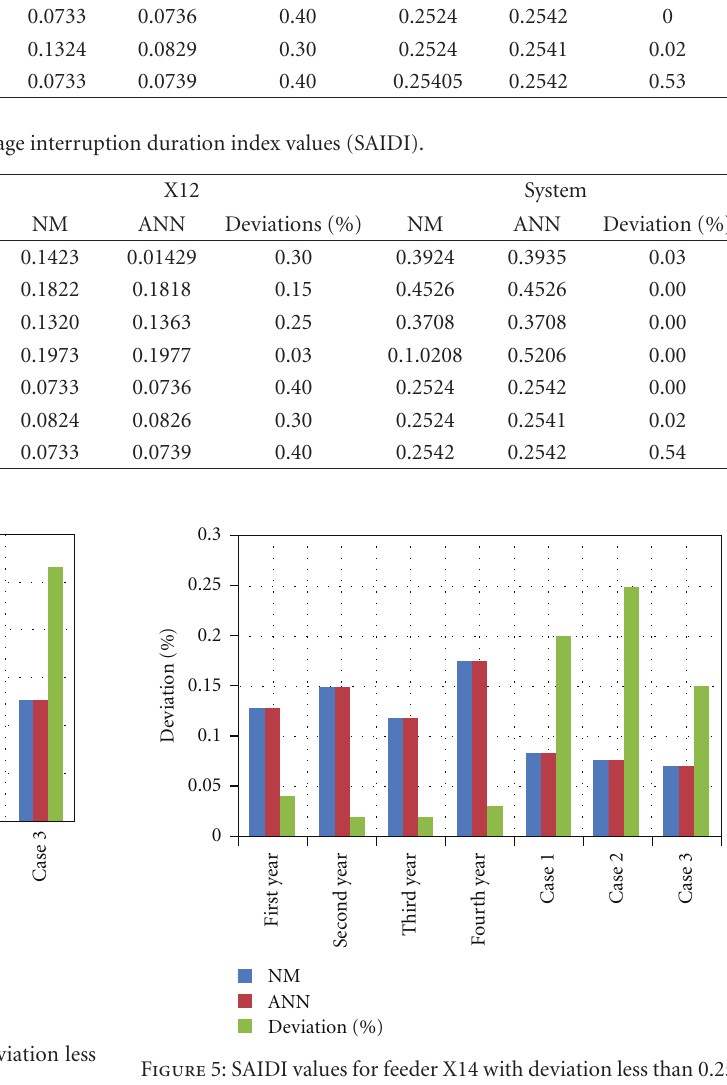
of lines, buses, circuit breaker, and transformer of each feed- er, this network contains 1809 nodes in the input layer, 18 nodes in output layer, and 100 nodes in the hidden